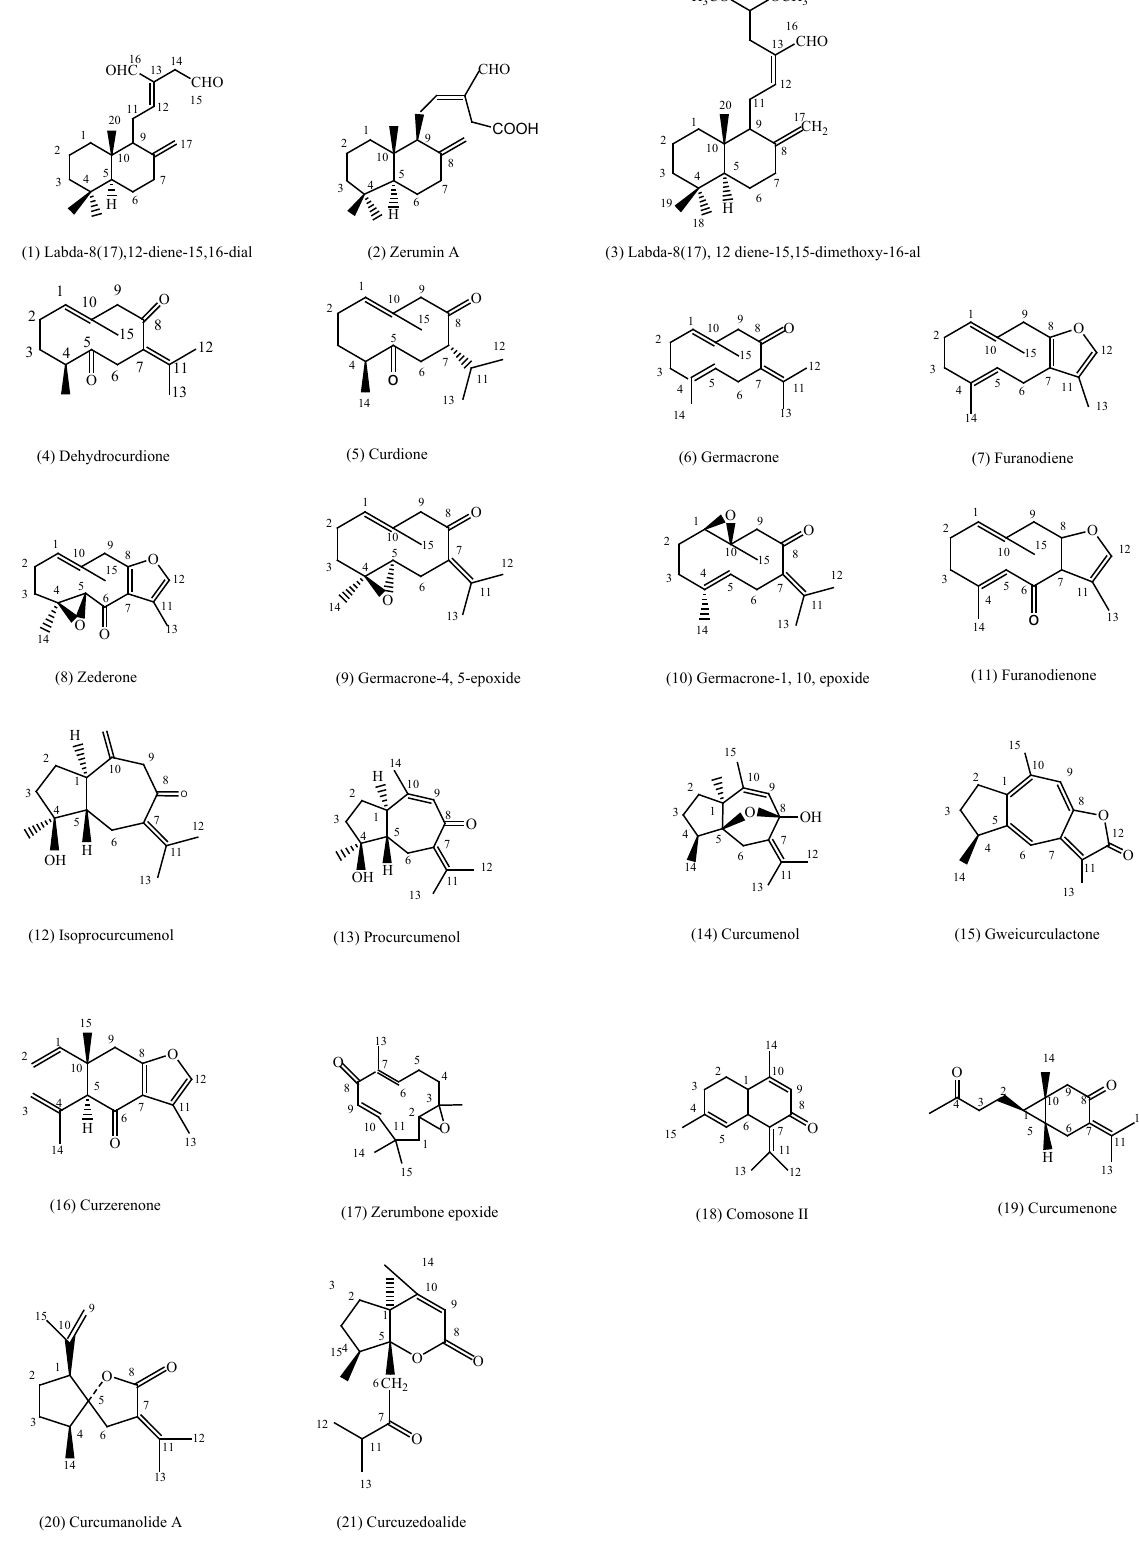
Figure 1. Structure of compounds isolated from C. zedoaria